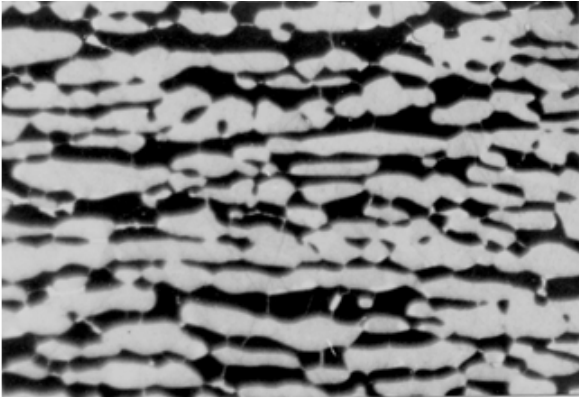
Figure 1. Microstructure of the AV2205 alloy solution annealed at 1050 °C for 30 min. Clear: austenite; dark: ferrite. 811X.